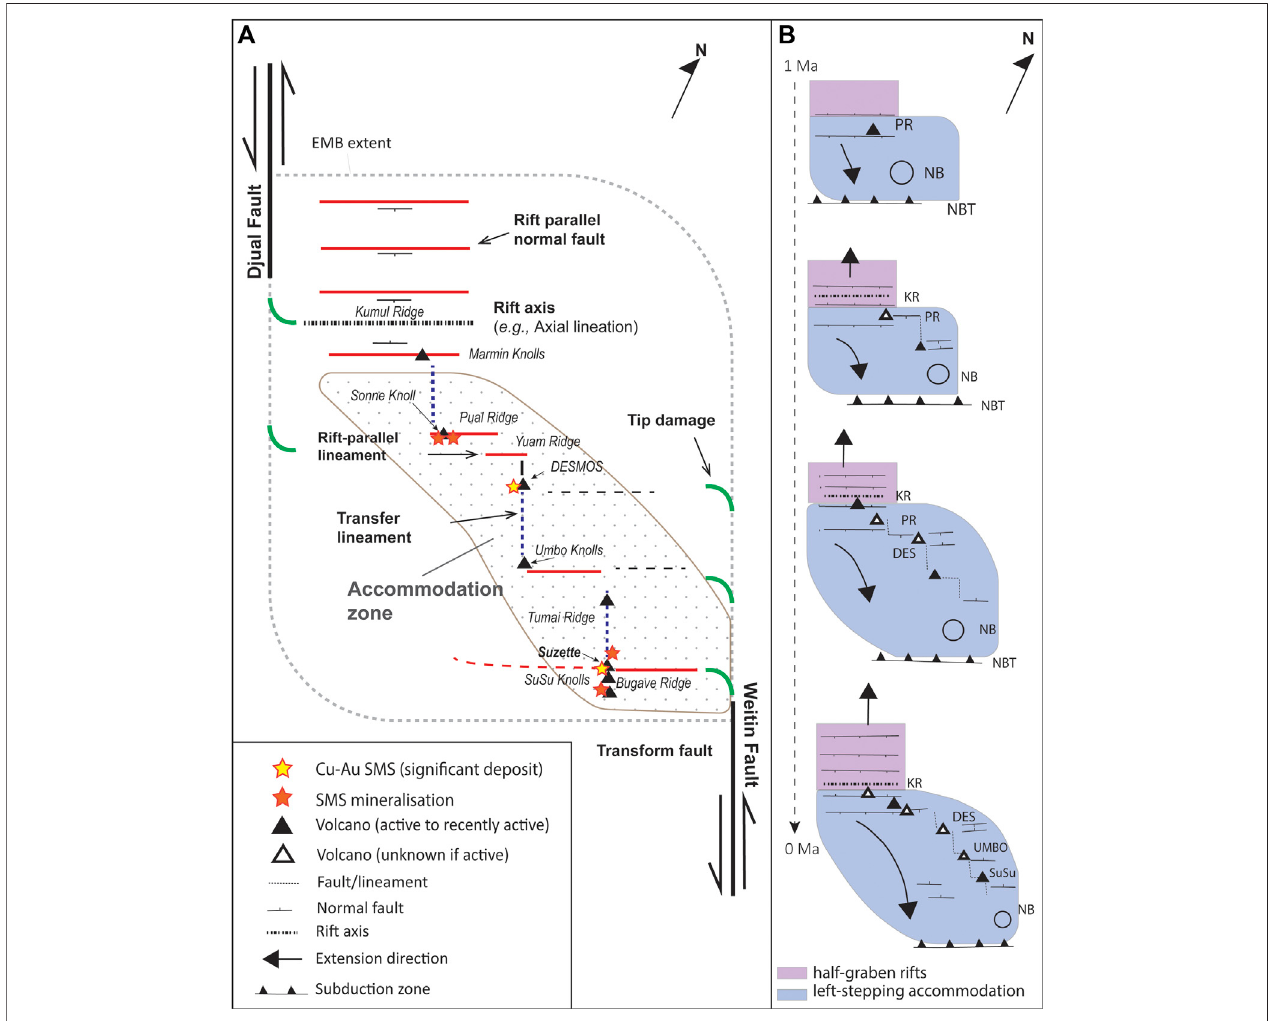
FIGURE 13 | Summary schematic showing the volcano-structural evolution of the EMB. (A) This simplistic schematic summarizes the variation between “ classic ” orthogonal rifting style in the northwest of the EMB (i.e. Kumul Ridge), and the southeast of the basin where extension is accommodated in a left-stepping accommodationzone.Themorecomplexaccommodationzonehoststhesigni fi cantsea fl oormineralizationdiscoveredintheEMB.Speci fi cally,mineralizationdevelops where cross-cutting structures intersect. Structural terms come from Gibbs (1984); Karson and Rona (1990); Mauduit and Dauteuil (1996); Kim et al. (2004); Wu et al. (2009); Peacock et al. (2016). (B) A schematic interpreting the ∼ 1 Myr evolution of the EMB. Pull-apart rifting generating the half-graben rifts is interpreted to occur on the North Bismarck microplate; the left-stepping accommodation zone is interpreted to represent extension through the South Bismarck microplate. Note that the Pual Ridge and the Kumul Ridge are assumed as relatively stationary. Abbreviations: PR, Pual Ridge; KR, Kumul Ridge; DES, DESMOS, UMBO, Umbo Knolls; SuSu, SuSu Knolls (including Suzette, North and South Su); NB, New Britain (Gazelle Peninsula, identi fi ed by open circle); NBT, New Britain